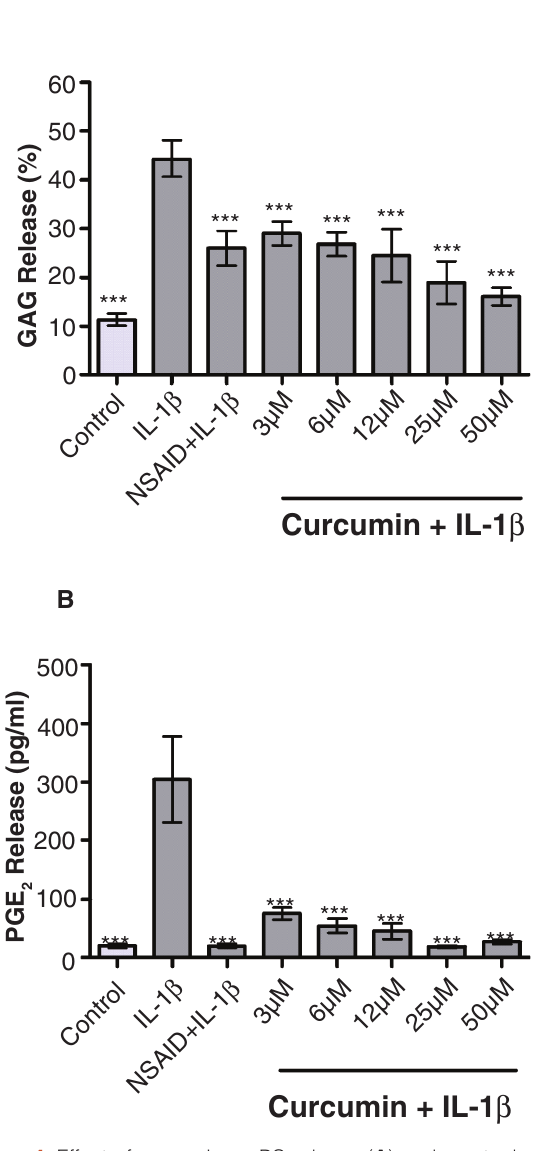
Figure 4. Effect of curcumin on PG release ( A ) and prostaglandin E2 (PGE ) ( B ) from interleukin (IL)-1 β -stimulated cartilage explants 2 (dark grey columns) (n=3). Control (light grey column) indicates cartilage discs incubated in the culture medium alone. Values are reported as the mean of three animals per treatment ± SEM. Data are from 3 different animals, with three technical replicates per animal. Significance compared to IL-1 β is indicated by * ( p <0.05), ** ( p <0.01) and *** ( p <0.001). IL-1 β significantly increases proteoglycan (PG) ( p <0.001) and PGE ( p <0.001) release compared to control. The 2 non-steroidal anti-inflammatory drug (NSAID) carprofen (100μg/ml) significantly reduces IL-1 β -stimulated PG ( p <0.01) and PGE 2 ( p <0.001) release. Curcumin significantly reduces IL-1 β -stimulated PG release at 3μM ( p <0.05), 6μM ( p <0.01), 12μM ( p <0.01), 25μM ( p <0.001) and 50μM ( p <0.001). IL-1 β -stimulated PGE release is 2 also significantly reduced at all curcumin concentrations ( p <0.001). PG loss is expressed as sulfated glycosaminoglycan (GAG)